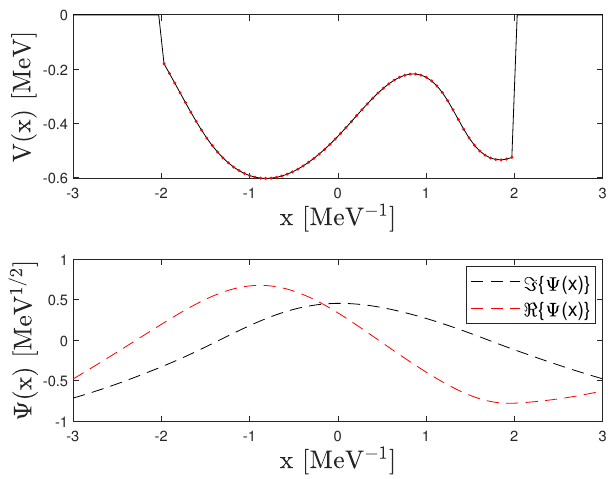
Figure 10. Solution of the Lippmann–Schwinger equation for the potential function shown in the upper figure for an initial wave function e ikx , with k = 0.5 MeV. The part of the potential marked by red dots are the values, which are used as outputs of the system. The lower figure shows the imaginary and real values of the scattered wave function, which are used as inputs of the Volterra